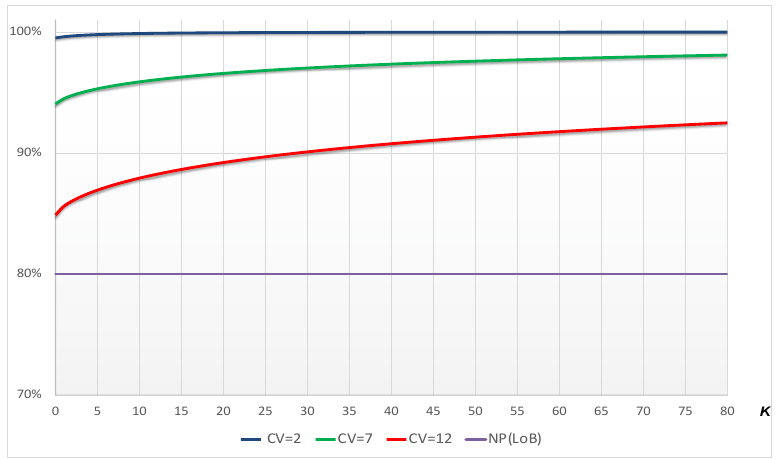
Figure 3. Gross-to-net coefficient of variation (CoV) for different c ˜ multiplicative factor k